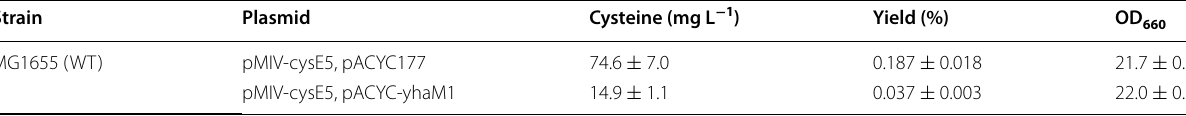
Values represent the averages based on five independent experiments and the error value represents one standard deviation. To retain the plasmids, 20 μg mL − 1 kanamycin and 25 μg mL − 1 chloramphenicol were added. Cultivation was terminated at 21–24 h after inoculation when all the sugar (40 g L − 1 ) had been consumed